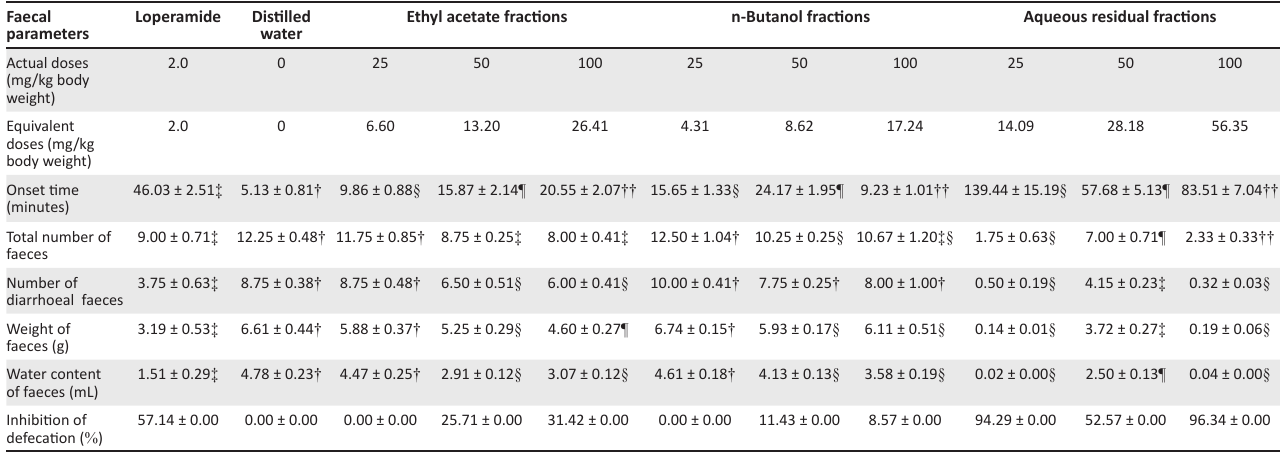
TABLE 1: Effects of the solvent–solvent fractions of aqueous extract of Mangifera indica leaves on castor oil-induced diarrhoea in female Wistar rats. Faecal